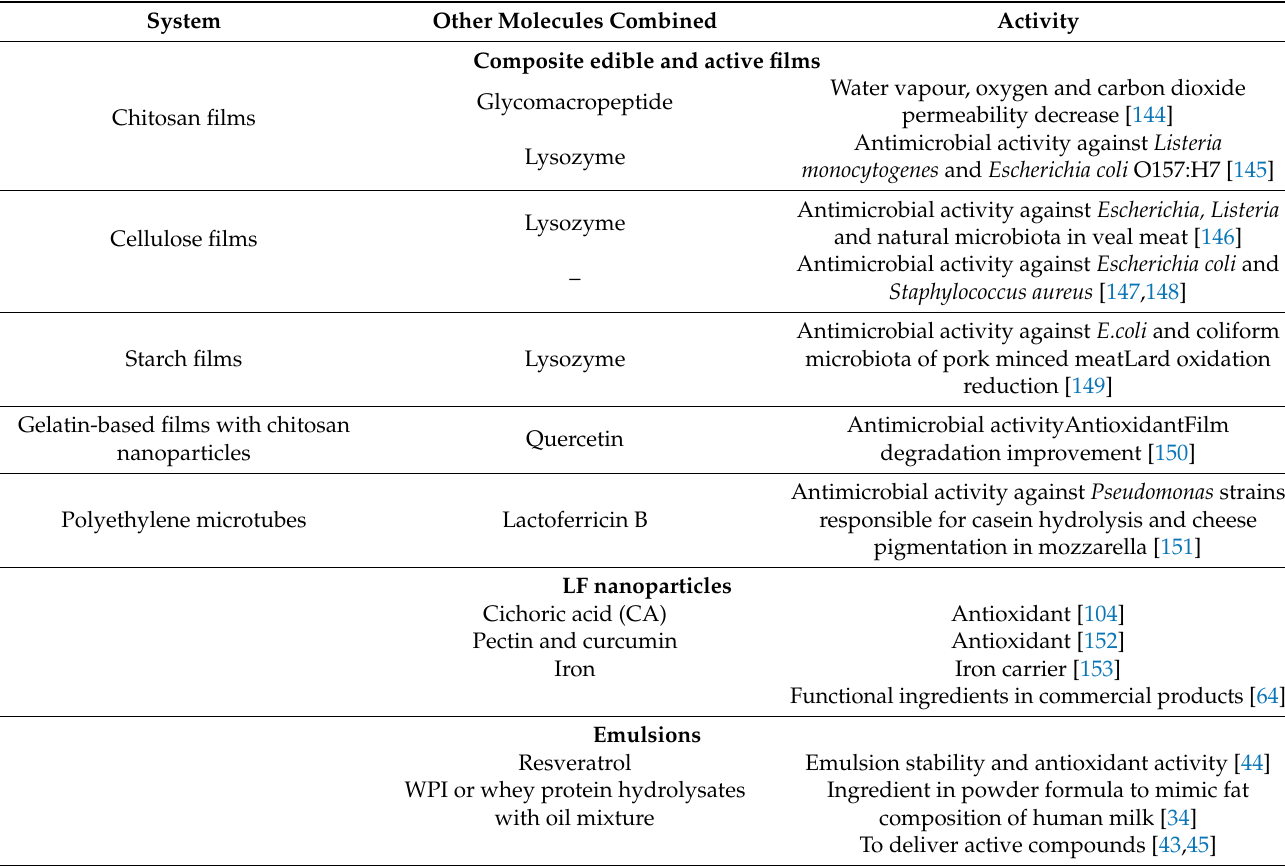
Table 2. Studies regarding the use of lactoferrin in different systems for applications in food technology.